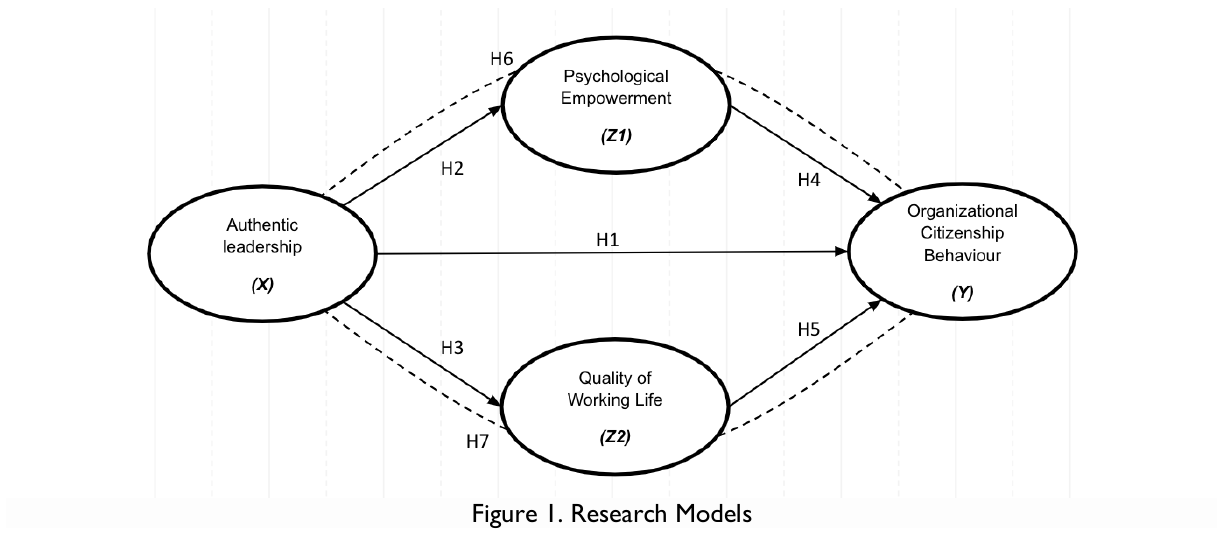
Figure 1. Research Models